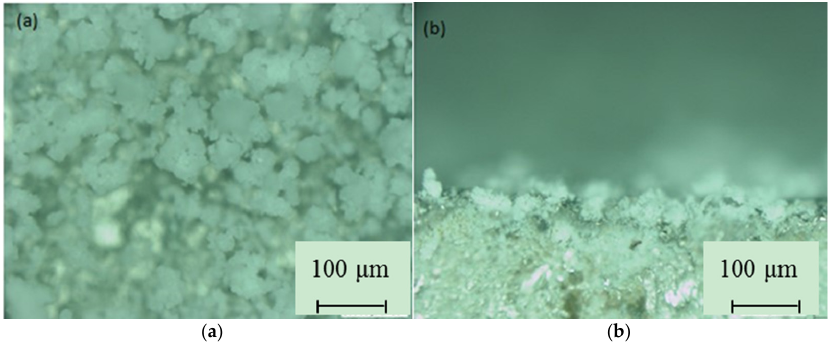
Figure 8. XRD patterns of SPS films after heat treatment ( d = deposition distance, ● : Anatase, ■ : Fe (substrate)). Figure 9. Micrographs of suspension sprayed coating deposited at d = 60 mm. ( a ) Top ‐ surface; ( b ) Cross ‐ section.